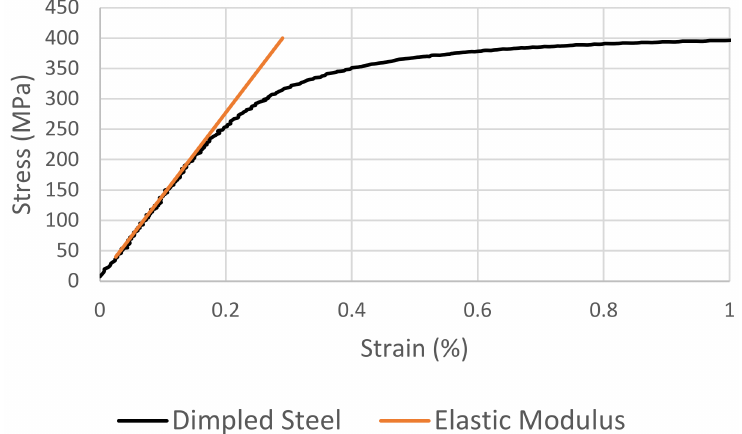
Figure 5. Low-strain region of a typical stress–strain curve for dimpled steel exhibiting ‘severely continuous